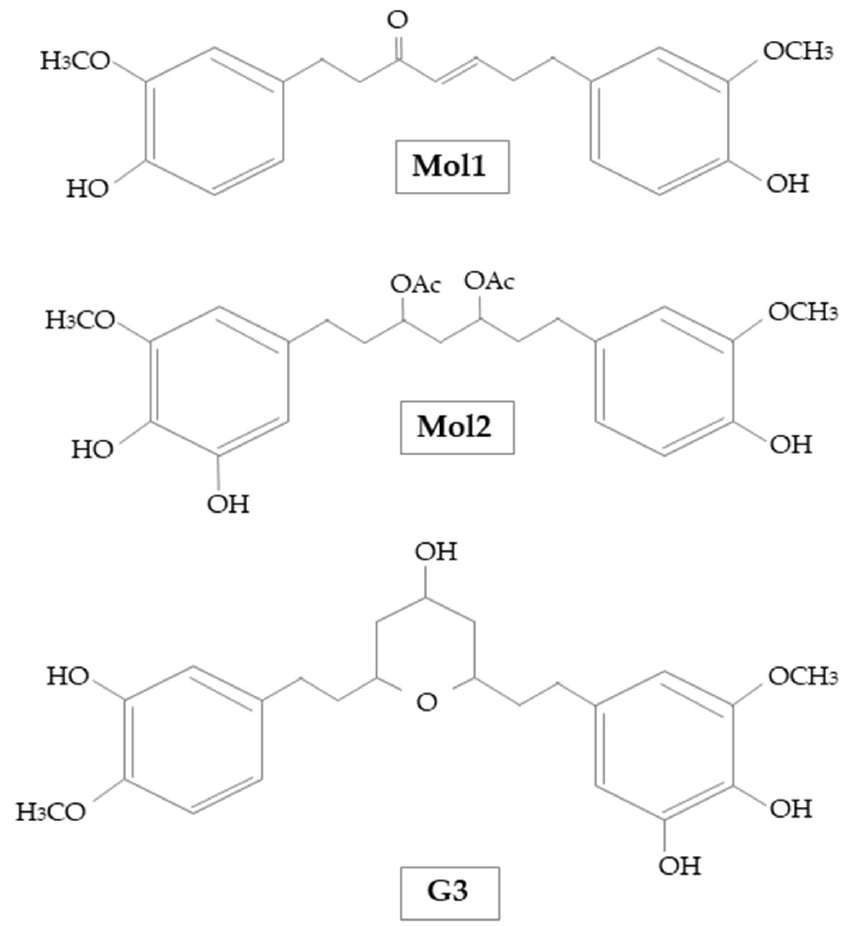
Figure 3. Chemical structure of Mol1, Mol2, and G3 used by Cuya et al. [42,43]. The potential effect of zerumbone as a cholinesterase inhibitor was evaluated by Hwang et al, in vitro by enzyme assays, in silico docking, and simulation of absorption, distribution, metabolism, excretion, and toxicity. The results of the study demonstrated that zerumbone inhibited AChE and BChE, assessed by an anticholinesterase activity assay and measured by zerumbone kinetics. Moreover, it has been shown through computational docking that zerumbone inhibited the AChE activity by different binding sites including TYR72, ASP74, LEU76, TYR124, TRP286, PHE297, TYR337, and TYR341. Zerumbone also inhibited the BChE activity using the binding sites ASP70, TRP82, PHE329, TYR332, TRP430, and HIS438. Furthermore, thanks to its high permeability through the BBB, zerumbone has been suggested for the role of inhibitor both of AChE and BChE. Overall, the computational studies have shown a potential efficacy of ginger in the prevention of AD